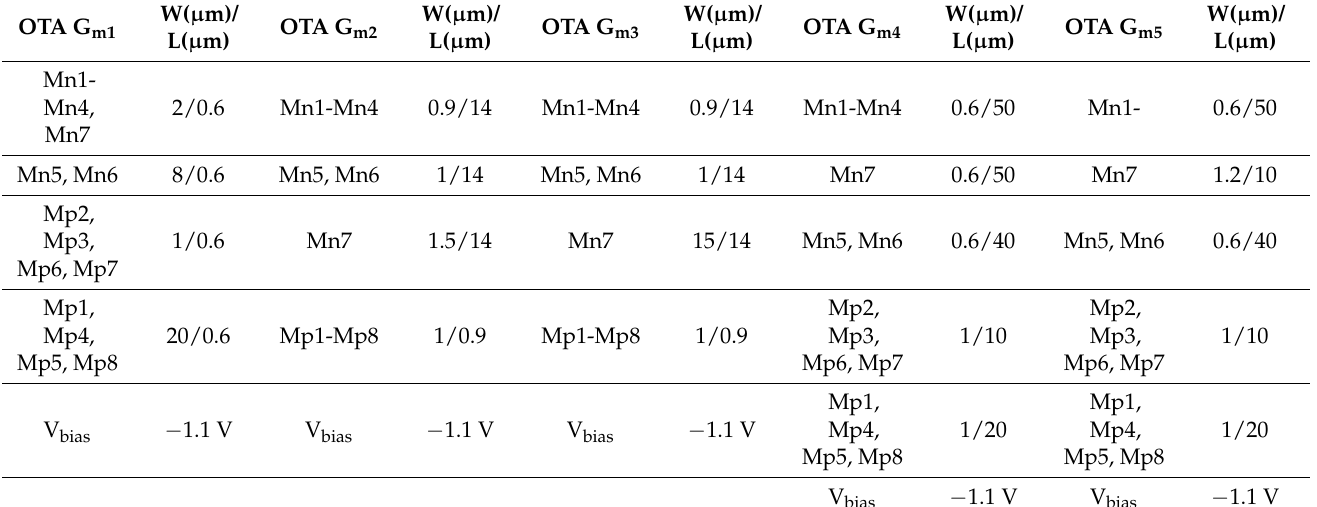
Table 4. Transistor values for each OTA